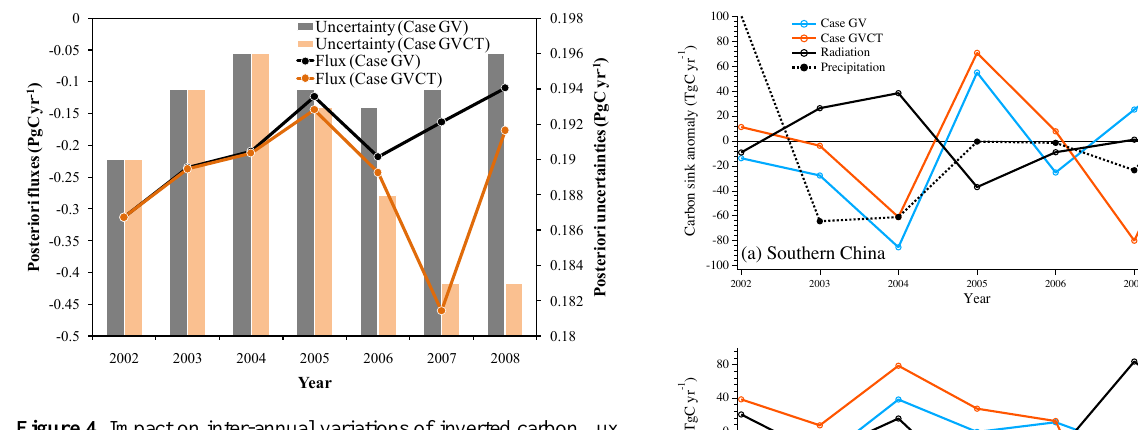
Figure 4. Impact on inter-annual variations of inverted carbon flux and posterior uncertainty in China.